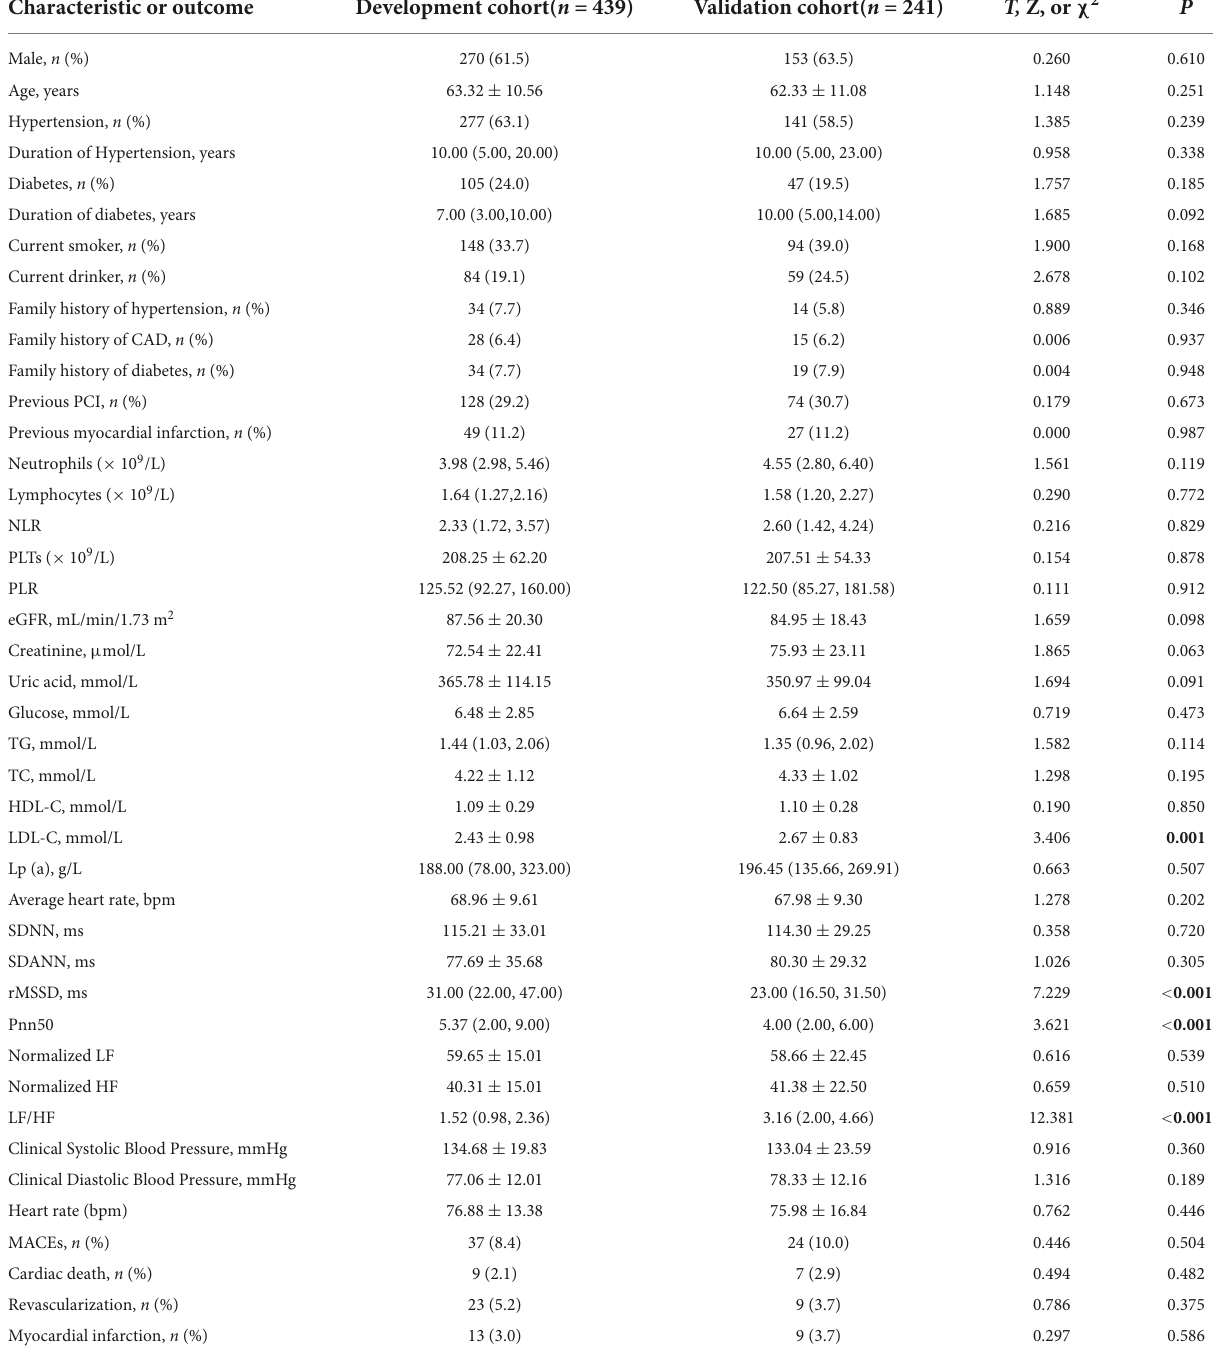
TABLE 1 Baseline characteristics and MACEs (clinical outcome) of patients in the development and validation cohorts*. Characteristic or outcome Development cohort( n = 439) Validation cohort( n =